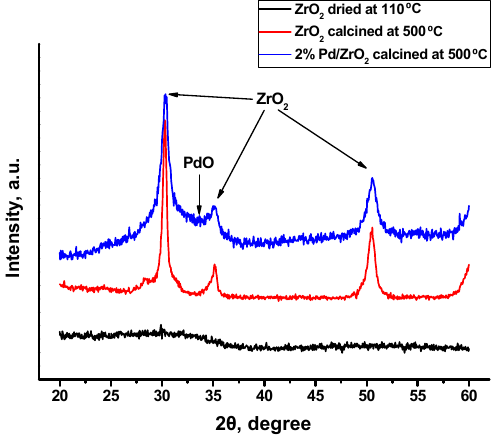
Figure 1. X-ray diffraction patterns for the pristine ZrO 2 (dried at 110 °C and calcined at 500 °C) and 2% Pd/ZrO 2 (calcined at 500 °C). Table 1. Specific surface area of pristine ZrO 2 , 0.2% Pd/ZrO 2 and 2% Pd/ZrO 2 . Sample